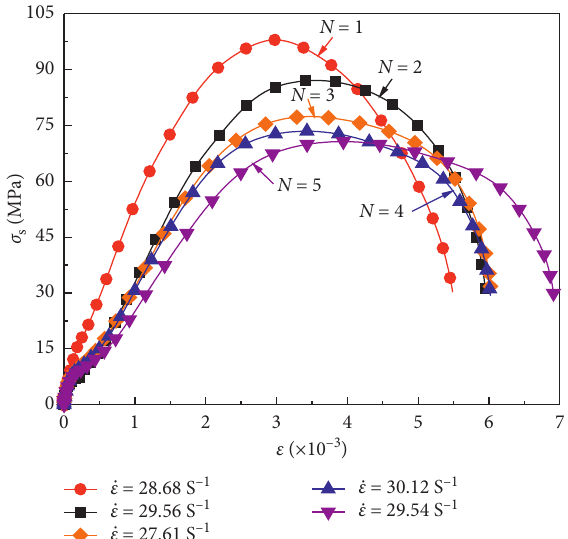
Figure 6: Stress-strain curves of the CJ5-Db specimen.